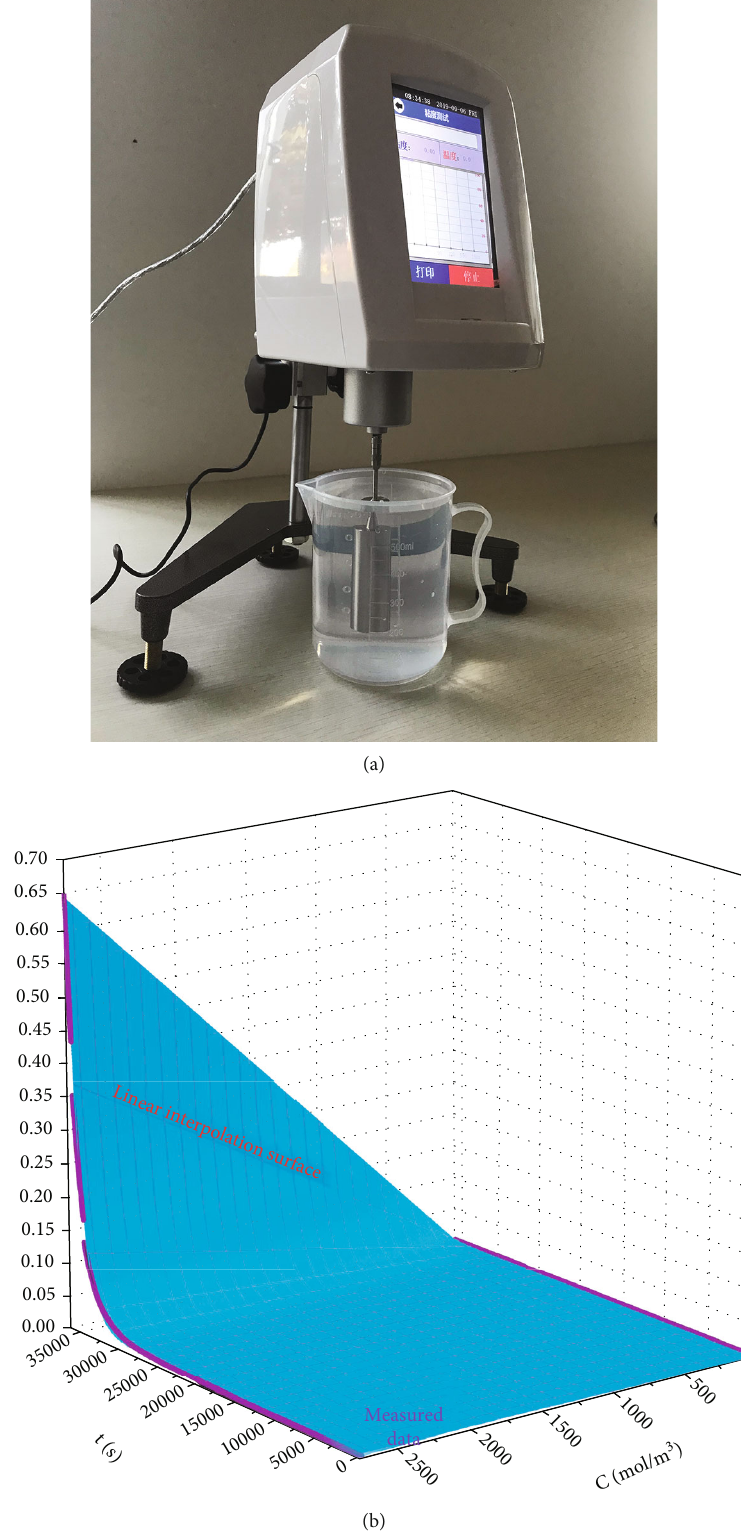
Figure 3: Rotation viscosity experiment: (a) NDJ-5S rotary viscometer; (b) linear interpolation three-dimensional surface of viscosity with time and concentration for